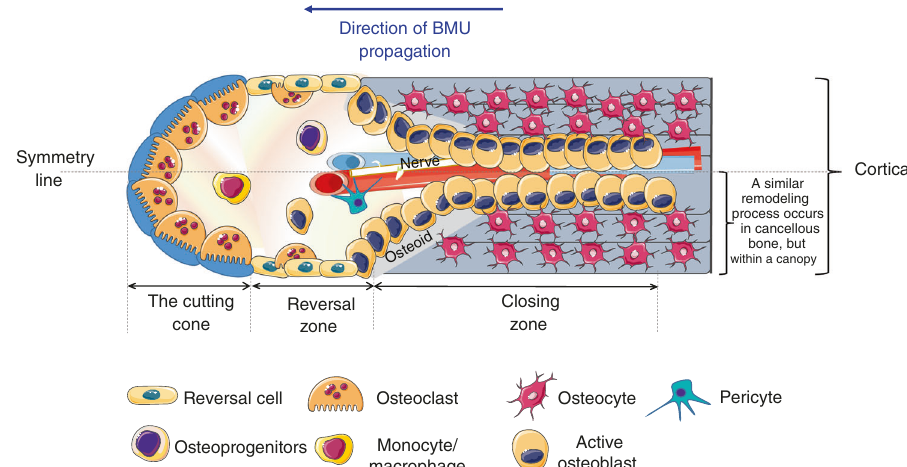
Fig. 1 The cutting cone. The cutting cone originates in close proximity to neurovascular axial bundles and is generated by the propagation of the basic multicellular unit (BMU). The cutting cone consists of a set of osteoclasts, followed by a set of osteoblasts, reversal cells and secondary osteoclasts that cover the so-called reversal zone. At the end of the reversal zone, a set of osteocytes generate the closing zone. A line of symmetry divides in half the representation of a complete BMU in the cortex moving toward the longitudinal axis of the long bone. One-half of cortical BMU is similar to the BMU at the cancellous surface, although in cancellous bone, the BMU is separated from the marrow by a speci fi c cell structure called the